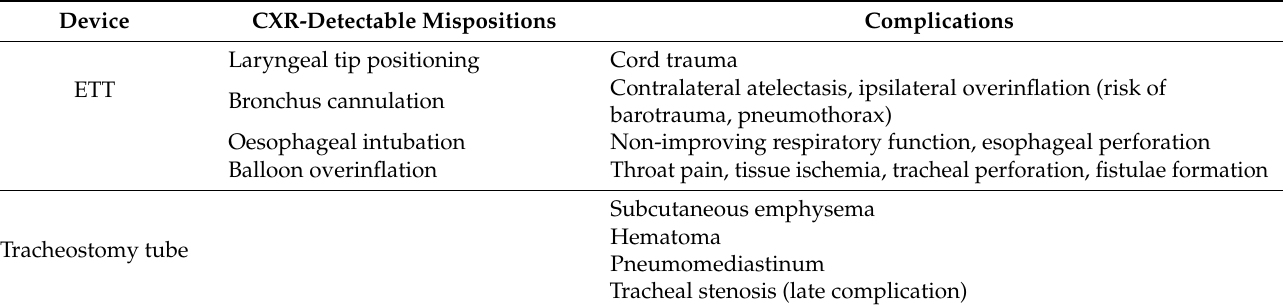
Table 3. Airway devices’ most frequent CXR-detectable mispositions and respective complications.